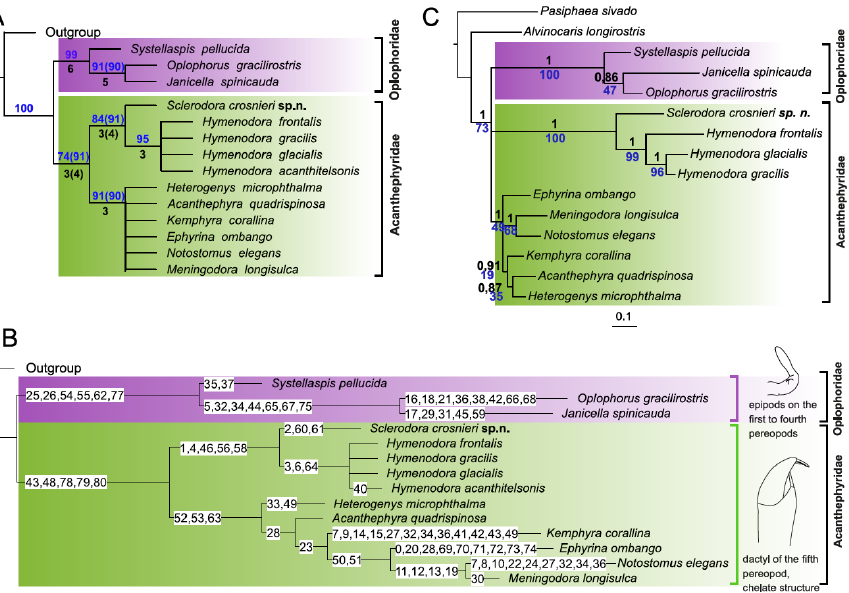
Figure 2. Phylogenetic trees with Pasiphaea sivado and Alvinocaris longirostris as outgroups. ( A )— morphological MP tree; only clades supported by both Bremer values (black, below branches) and bootstrap values (blue, above branches) are shown; if support values in analyses differed, values retrieved in Analysis 2 are given in parentheses. ( B )—synapomorphies, above branches, see coding in File S1. ( C )—molecular BI and ML tree, only supported clades are shown. The horizontal scale bar marks the number of expected substitutions per site. Statistical support indicated as Bayesian posterior probabilities (black, above branches) and ML bootstrap with 1000 replicates (blue, below branches).